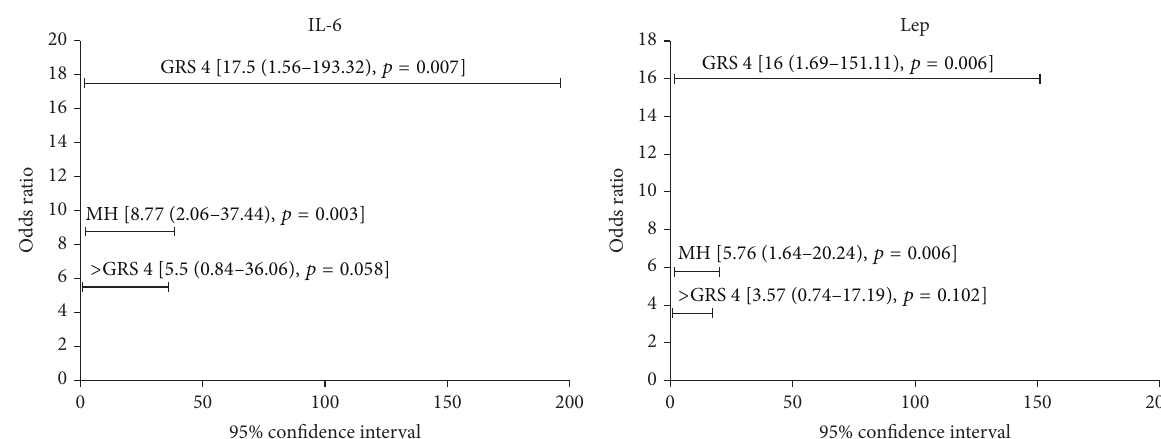
Figure 5: Association analysis of IL-6 and leptin with obesity among patients with and without taste alteration according to the GRS 4. Odds ratio and corresponding 95% confidence interval were calculated to determine association of IL-6 and leptin with obesity, using the 90th percentile in the nonobese control group as cut-off levels. The total number of patients with GRS 4 is 6. The numbers of patients with GRS 4 and increased circulating levels of IL-6 and leptin were 5 and 4, respectively. The total number of patients with GRS > 4 is 24. The numbers of patients with GRS > 4 and increased circulating levels of IL-6 and leptin were 22 and 20, respectively. IL: interleukin, Lep: leptin, MH: Mantel-Haenszel common odds ratio estimate, and GRS: gustatory response